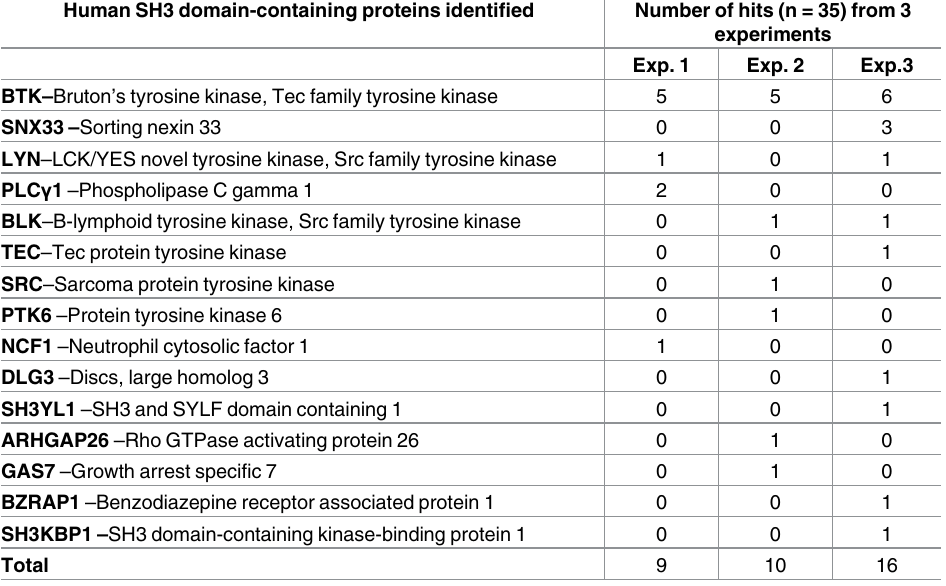
Table 1. SH3-domains identified by bio-panning of recombinant ANKRD54against a human SH3-do- main library. Human SH3 domain-containing proteins identified Number of hits (n = 35) from 3